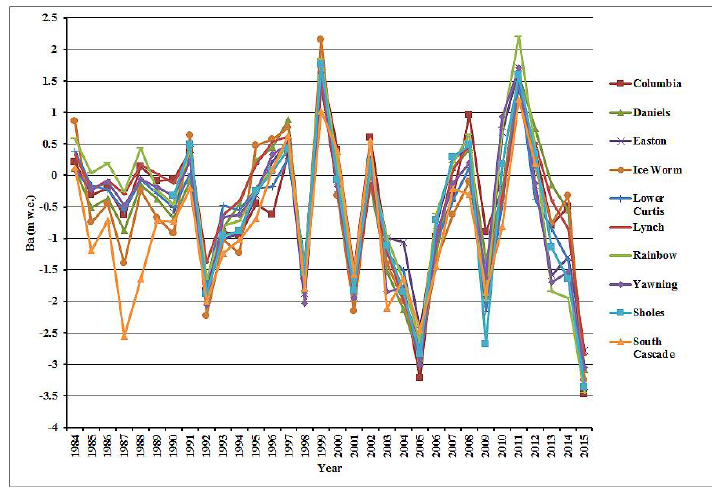
Figure 2. Mean annual balance of the North Cascade glaciers, indicating the similar annual response to climate forcing. Ba—annual mass balance.